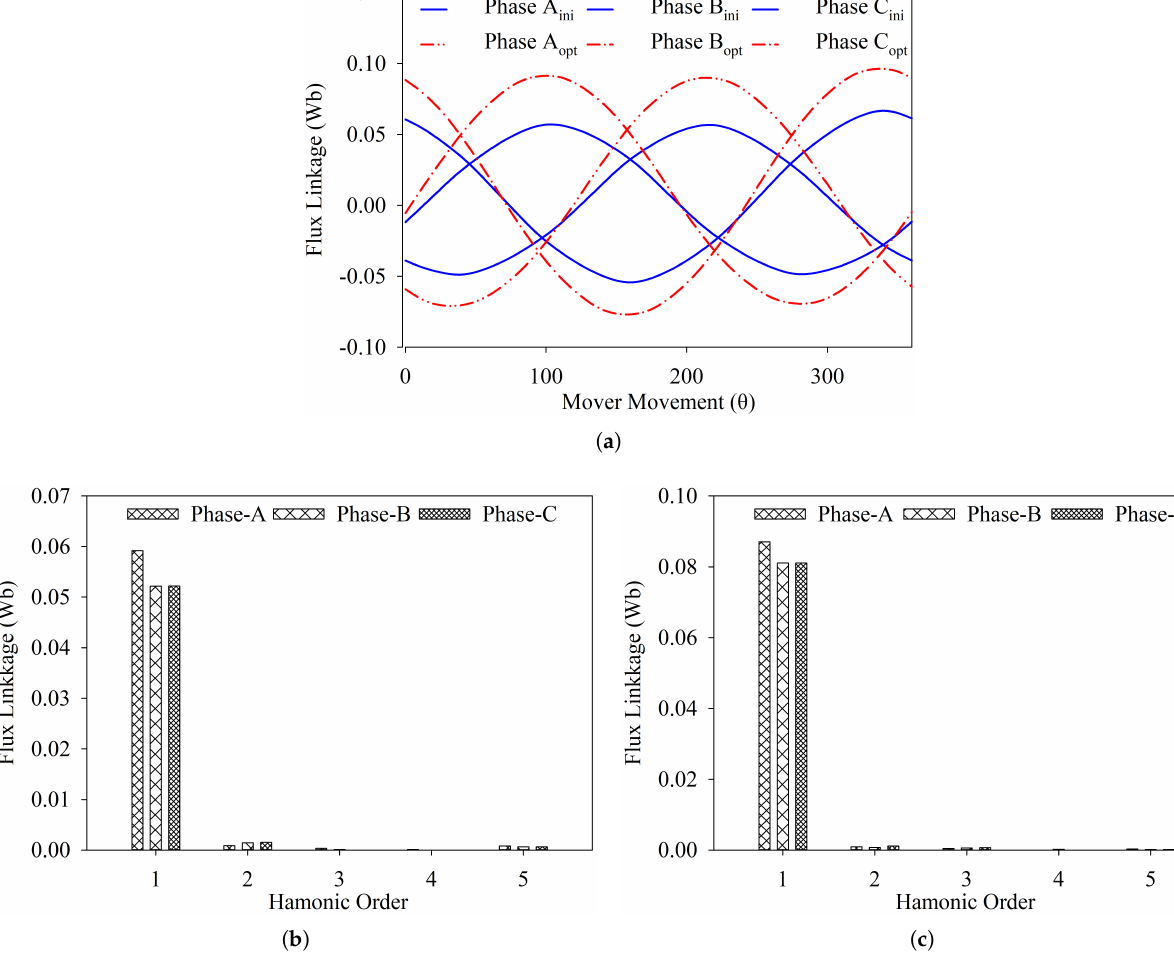
Figure 13. ( a ) Flux linkage of the proposed single-sided VFPMLM ( b ) Harmonics in initial design’s flux linkage ( c ) Harmonics in optimized design’s flux linkage.